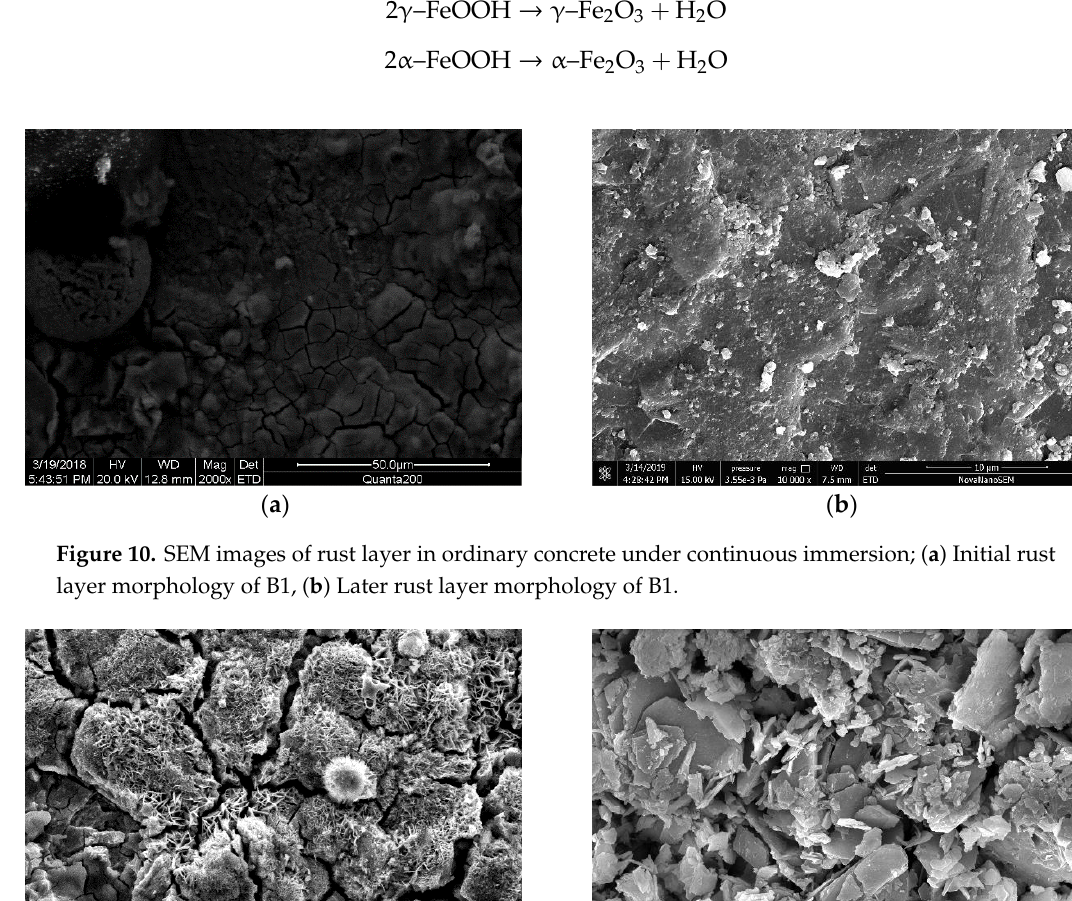
Figure 10. SEM images of rust layer in ordinary concrete under continuous immersion; ( a ) Initial rust layer morphology of B1, ( b ) Later rust layer morphology of B1.